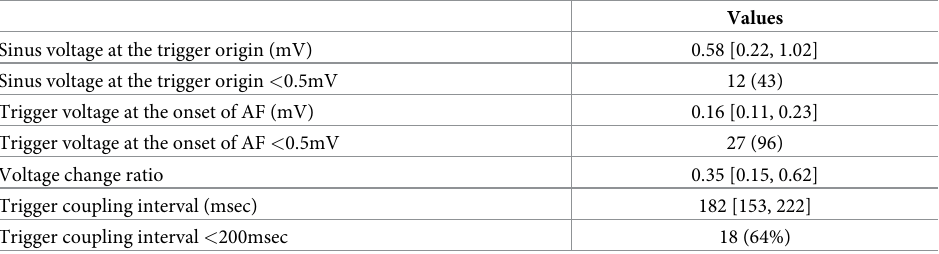
Table 2. Electrophysiological characteristics of non-PV